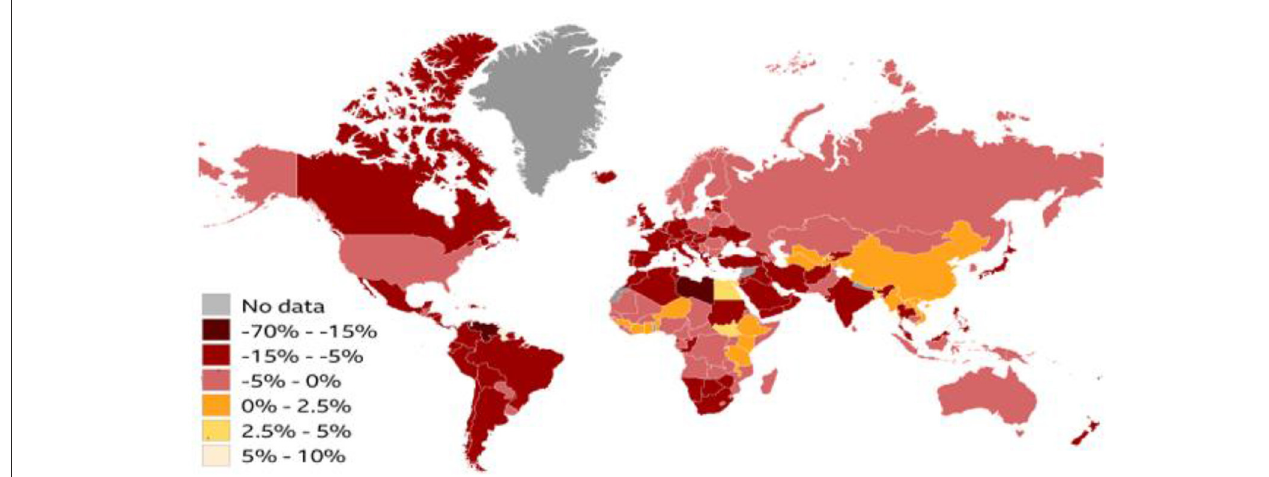
FIGURE8 Majority of countries in recession. Source: IMF.